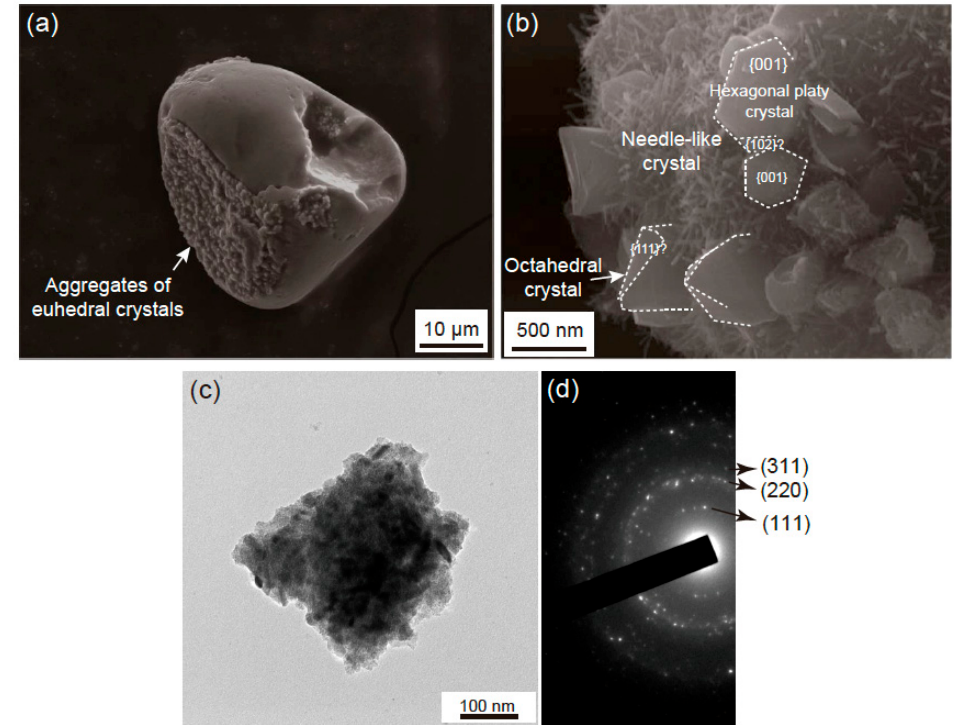
Figure 6. ( a,b ) FE-SEM images of samples recovered from run 3. ( a ) Several euhedral crystals formed aggregates on the rounded particle starting materials. ( b ) Needle-, hexagonal platy, and octahedral crystals were included in the aggregations. ( c ) TEM image of sample recovered from run 3 with ca. 400 nm aggregate of ca. 50 nm diameter particles. The aggregate showed spinel-like morphology.